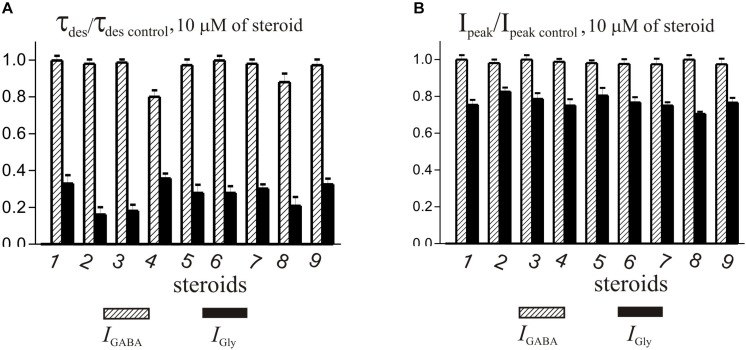
Comparison of the effects of NS on IGly and the IGABA. (A) Mean ± SEM of the normalized values of the time constant of desensitization (τdes) of IGABA (shaded columns) and IGly (black columns) in the presence of 10 μM of compounds 1-9. (B) Mean ± SEM of the normalized values of the peak amplitude of IGABA (shaded columns) and IGly (black columns) in the presence of 10 μM of compounds 1-9. Results show greater action of all nine compounds on the IGly than on the IGABA.